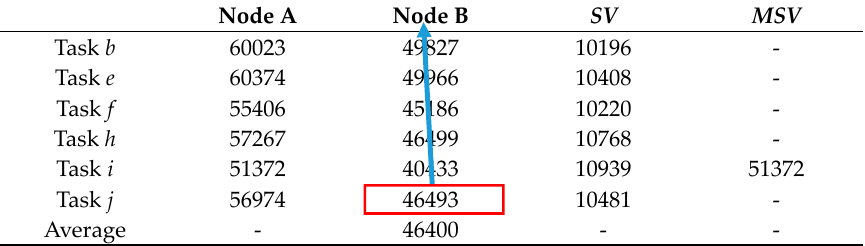
Table 11. Assigning tasks to the server nodes.